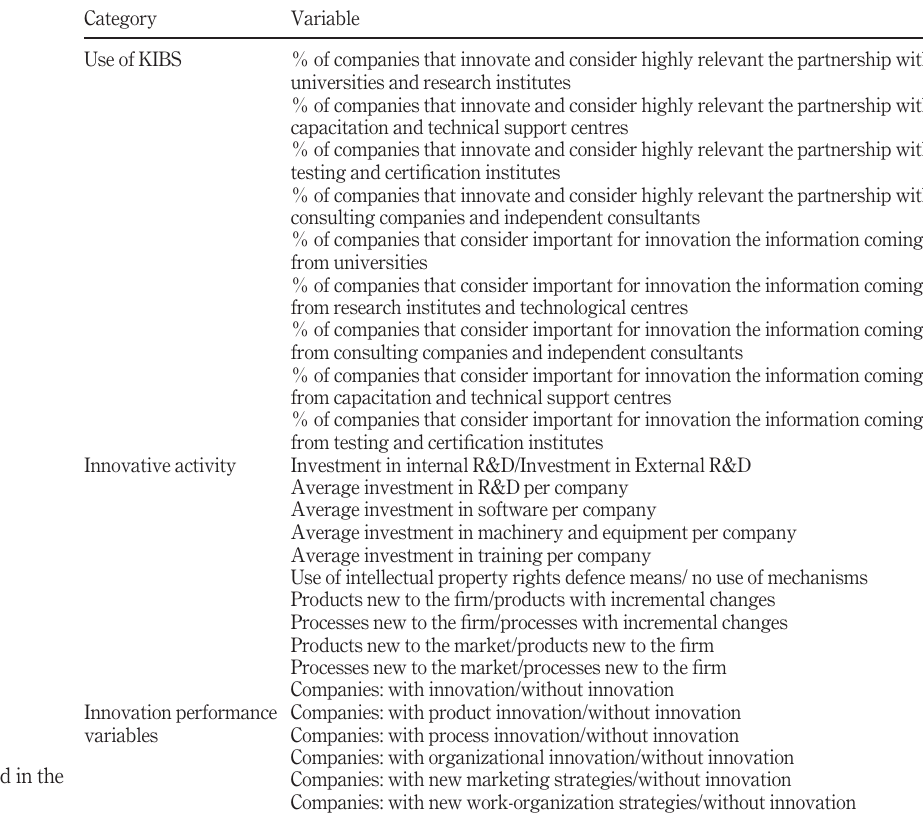
Table I. Variables used in the